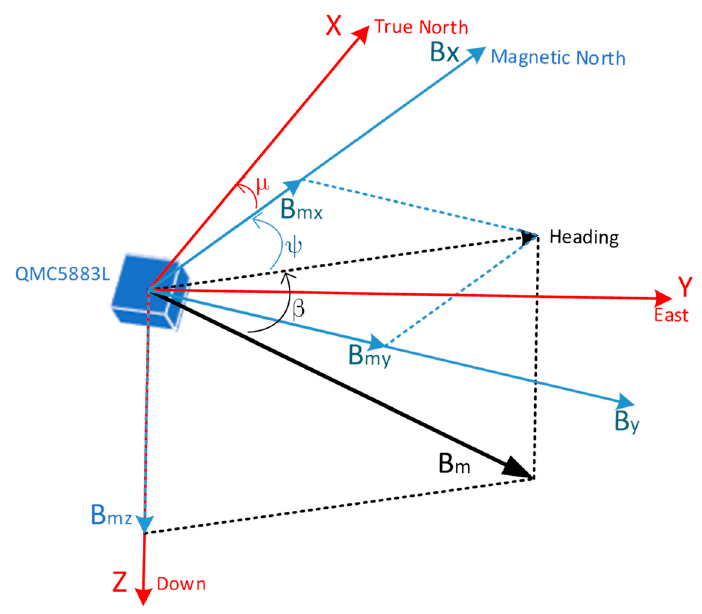
Figure 1. Schematic diagram of the geomagnetic signal model analysis.